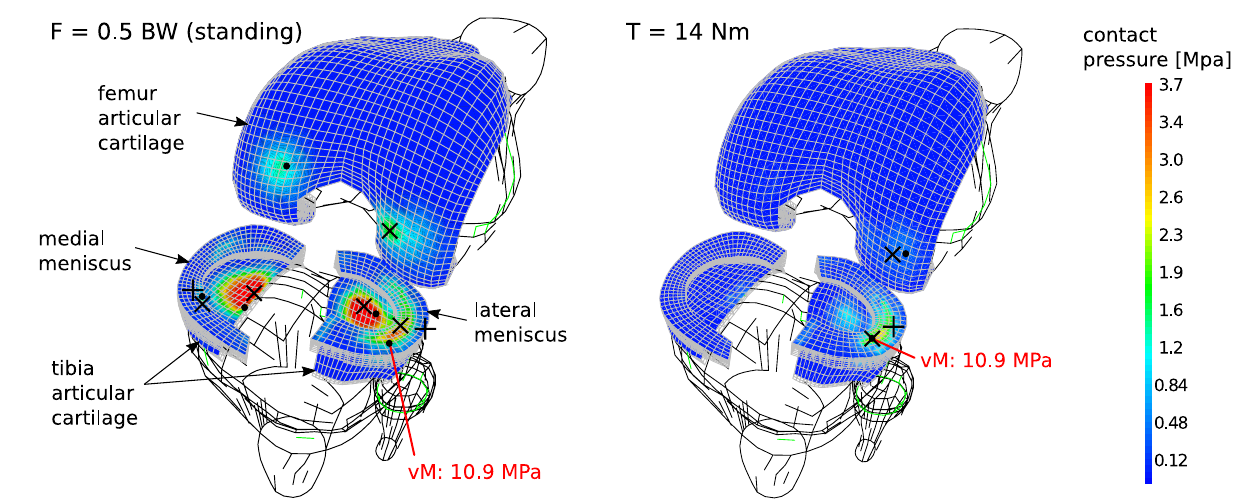
Figure 3. Comparison between the knee tissue stress estimators and deformations, for a typical load F occurring during still standing and for an “equally stressing” correcting moment T. •: location of maximum von Mises equivalent stress. × : location of maximum contact pressure. + : location of maximum menisci displacement. Tension in the medial collateral ligament due to the orthotic use was estimated in 77 N for this